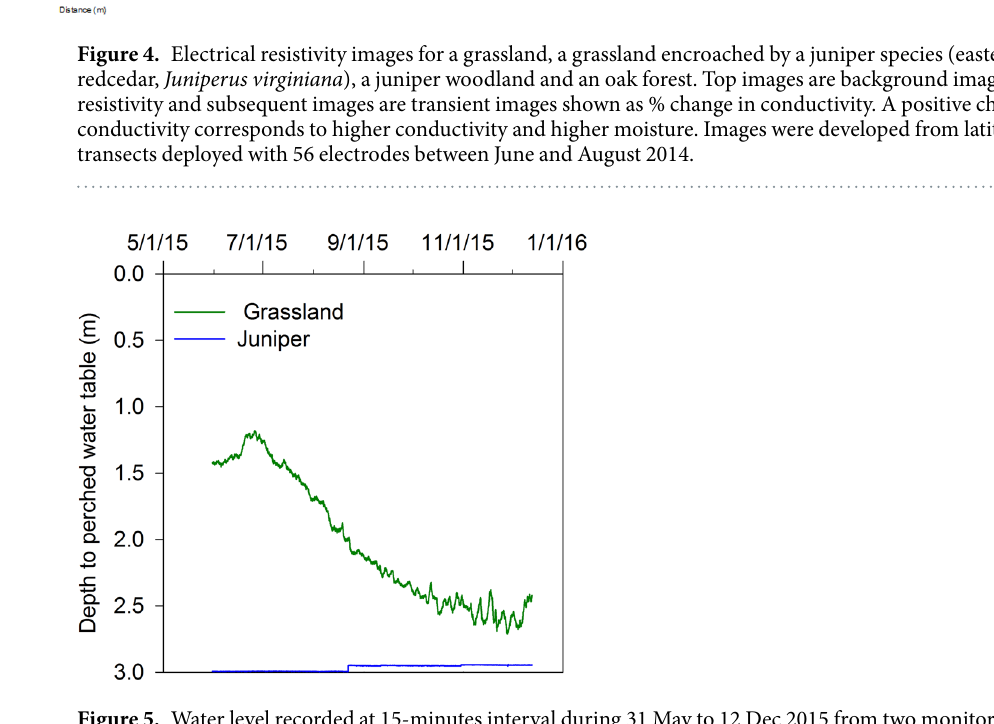
Figure 5. Water level recorded at 15-minutes interval during 31 May to 12 Dec 2015 from two monitoring wells of 3 m depth in a grassland and a juniper-encroached site. Wells were drilled in hydraulically conductive location inferred from ERI and piezometers were instrumented with CTD-10